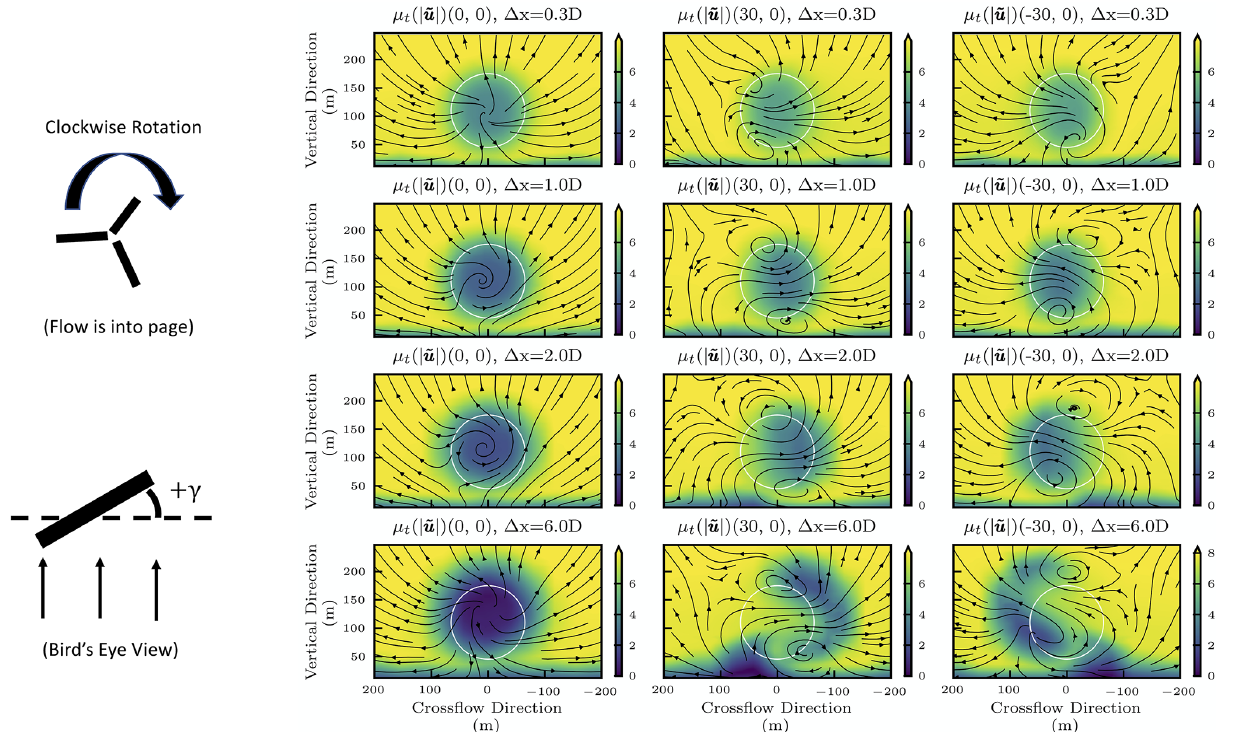
Figure 6. Flow fields associated with the extreme and neutral offsets in the front turbine, viewed from upstream. The (cid:49)x term indicates the distance downstream from the front turbine in terms of rotor diameters. Brighter colors show faster velocities. Streamlines show the direction of the cross-flow and vertical velocity components. In each plot, the vertical and cross-flow location of the back turbine is shown as a white circle. The turbines rotate clockwise when viewed from upstream. A diagram is shown on the left depicting the direction of positive yaw offset when viewing the turbine from above.